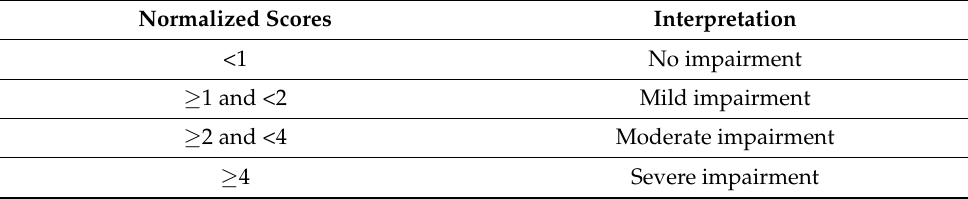
Table A1. Severity levels. Normalized Scores Interpretation <1 No impairment ≥ 1 and <2 Mild impairment ≥ 2 and <4 Moderate impairment ≥ 4 Severe